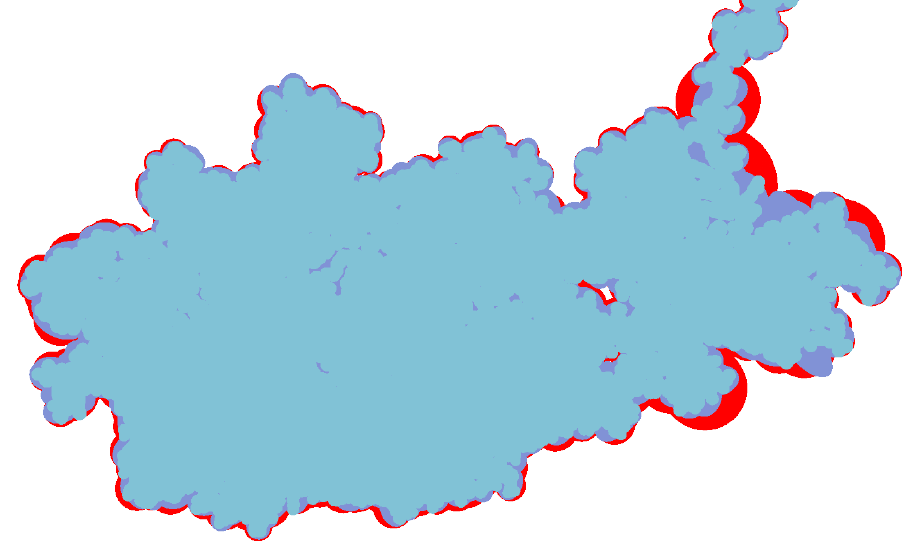
Figure 8. Overlap and comparison of three representations with constant shading. The bottom layer (coloured red) is bounding sphere model, the middle layer (coloured purple) is bounding ellipsoid model and the upper layer (coloured blue) is vdW